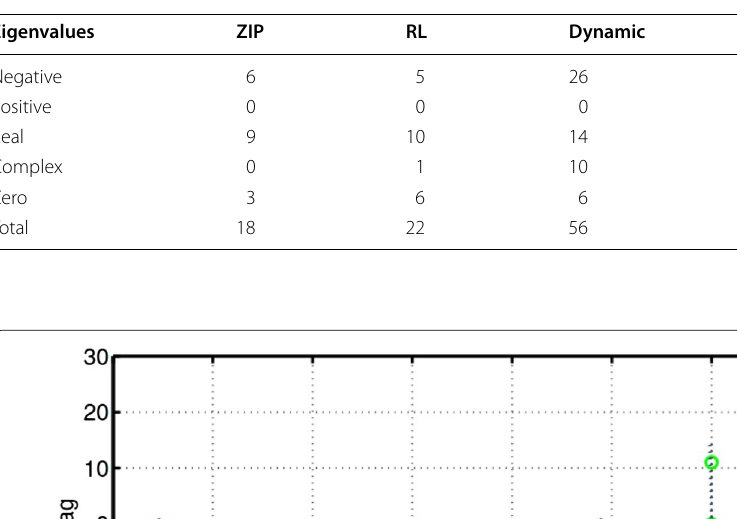
Table 5 Eigenvalues comparison for ZIP load, RL load, dynamic load and composite load model